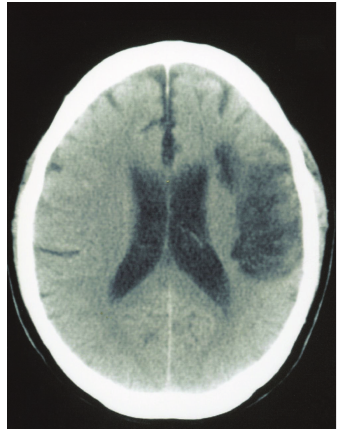
Figure 3: Axial Computed tomography of the brain 13 days after the carotid endarterectomy, demonstrated a new infarct in the white matter of the left frontal lobe